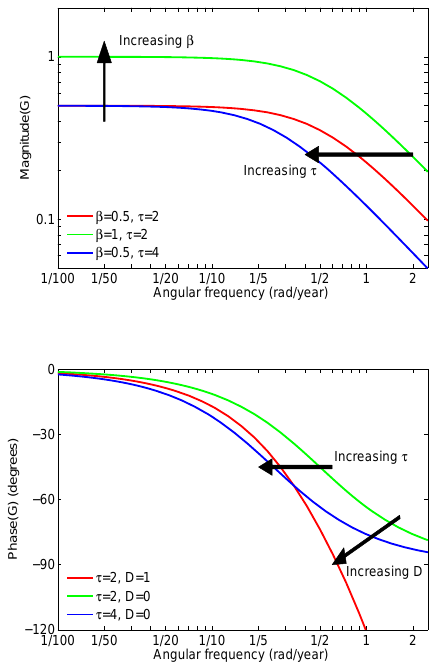
Figure 3. Bode plot showing the frequency response of the transfer function G ( s ) = e − sD β/ (1 + s τ ) for various values of β , τ , and D . The top panel shows the magnitude of the fre- quency response || G ( s ) || , and the bottom panel shows the phase φ = tan − 1 (Im( G ( s )) / Re( G ( s ))). β only affects magnitude, D only affects phase, and τ affects both. The red lines approximately cor- respond to the estimated response of Arctic temperature to Arctic insolation reduction in the 2 × 2 design example.